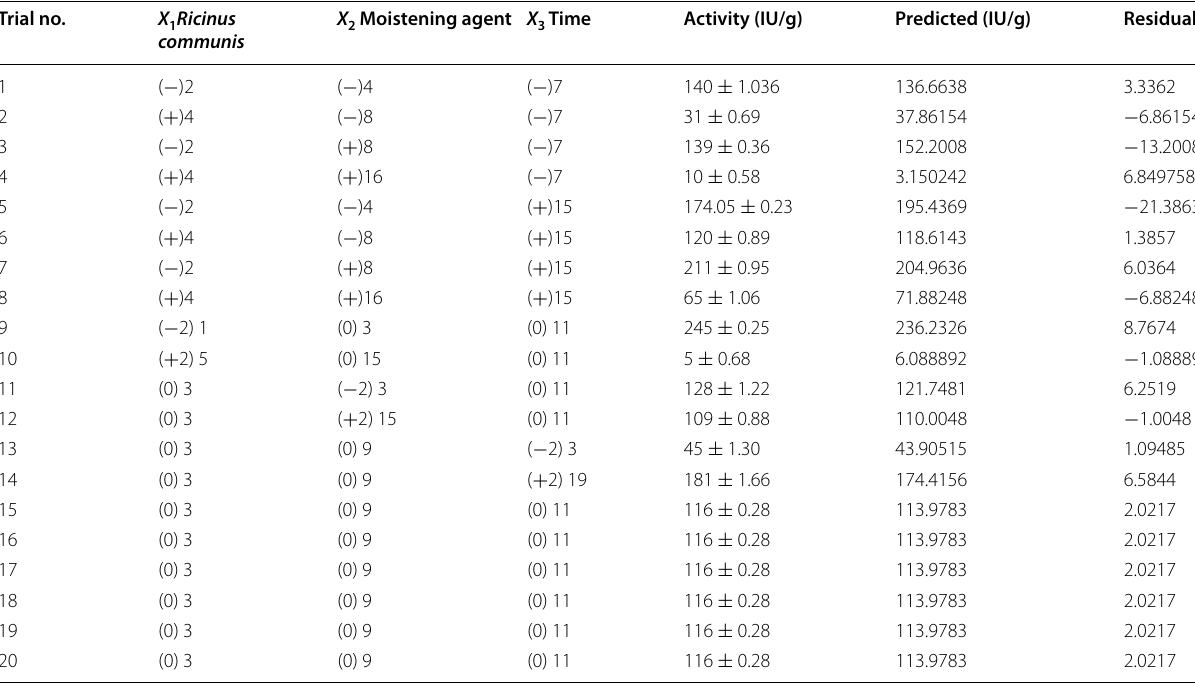
R-square, 0.98622; adjusted R-square, 0.972439. P -value: 2.69E-07